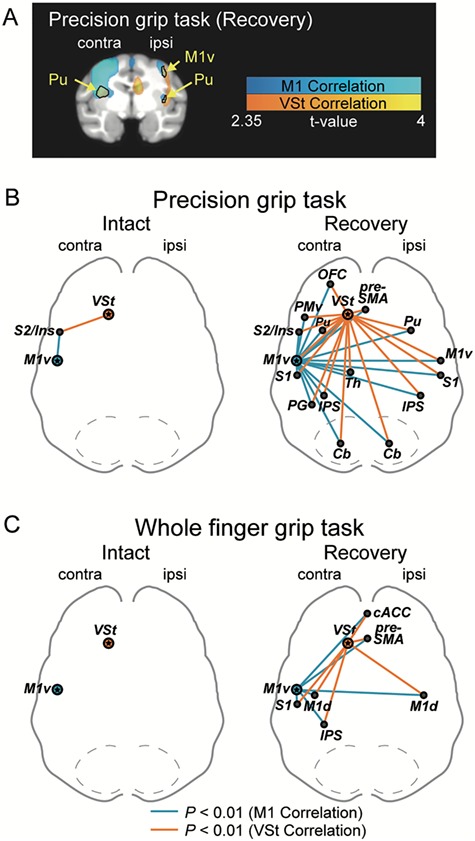
Overlapping functional connectivity between the VSt network and M1 network. (A) Example of overlapping functional connectivity. Brain regions with functional connectivity with the co-VSt (orange color, P < 0.01, uncorrected for multiple comparisons) and co-M1v (blue color, P < 0.01, uncorrected for multiple comparisons) are superimposed on the same template MRI. Overlapped areas are indicated by black outlines. Other brain areas are presented in Supplementary Figure 5. Results of the correlation analysis between the co-VSt and whole-brain are shown in Supplementary Figure 4 and Supplementary Table 6. (B and C) The functional connectivity with both co-VSt and co-M1v during (B) precision grip task and (C) whole finger grip task before and after SCI. Orange lines indicate significant functional connectivity with the co-VSt. Blue lines indicate significant functional connectivity with the co-M1v. Note that only brain areas having significant connectivity with both the co-VSt and the co-M1v are shown in these schemes (see Supplementary Fig. 3 and Supplementary Table 5 for results of correlation analysis with the co-M1 and Supplementary Fig. 4 and Supplementary Table 6 for results of correlation analysis with the co-VSt). contra, contralesional; ipsi, ipsilesional; OFC, orbitofrontal cortex; cACC, caudal anterior cingulate cortex; PMv, ventral premotor area; M1v, ventral aspect of the primary motor cortex; M1d, dorsal aspect of the primary motor cortex; S1, primary somatosensory cortex; S2, the secondary somatosensory cortex; Ins, insular cortex; PG, area PG in the posterior parietal cortex; Th, thalamus.